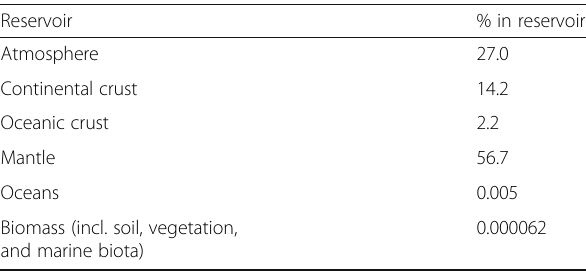
Table 1 Terrestrial nitrogen reservoirs (modified after Goldblatt et al. 2009; Palya et al.